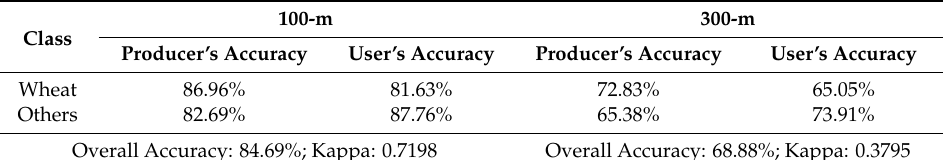
Figure 8. Classification results of the time-series 300-m data over the study areas: ( a ) Site 1; and ( b ) Site 2. Table 7. Classification accuracies of the 300-m and 100-m time-series data at Site 1.